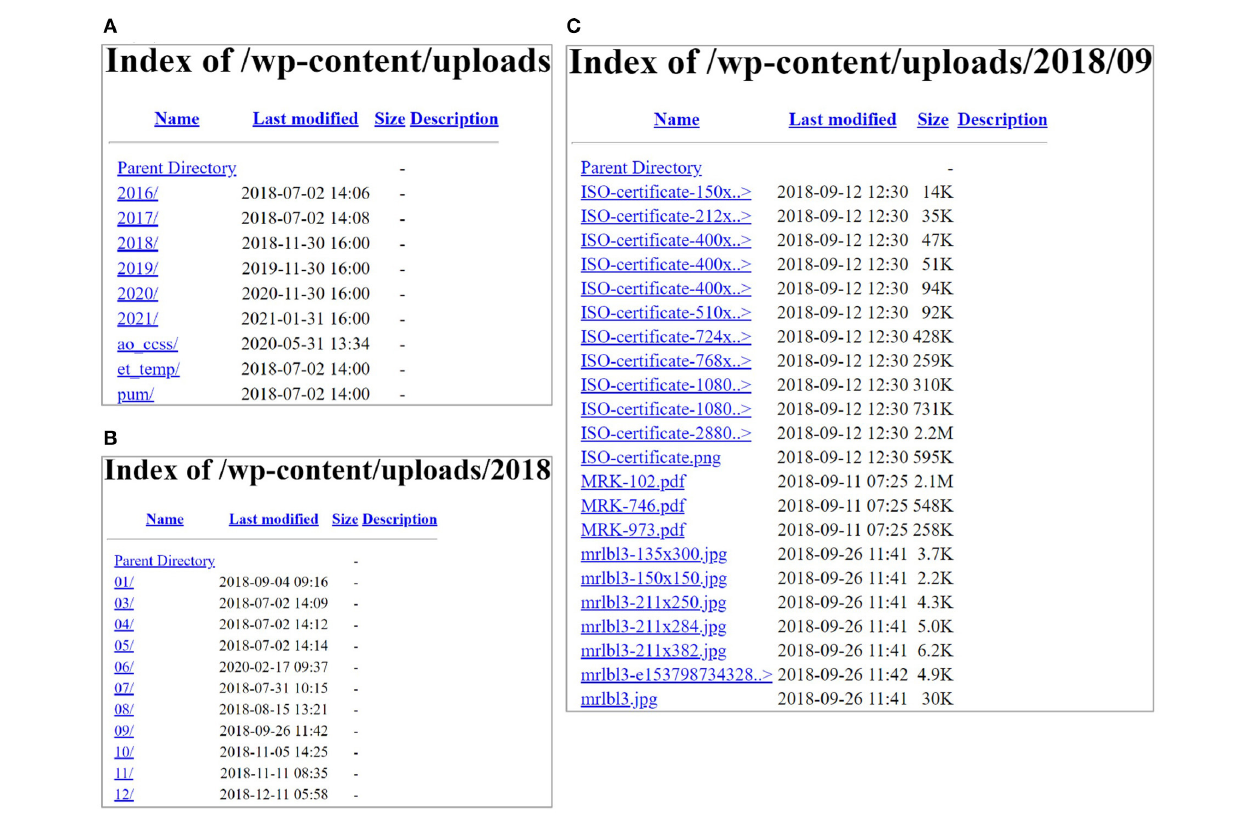
FIGURE 3 | (A) Content of the website screenshots from Charm Sciences page (https://www.charm.com/wp-content/uploads/); (B) contents of the year 2018 in (A) ; and (C) contents in one of the months